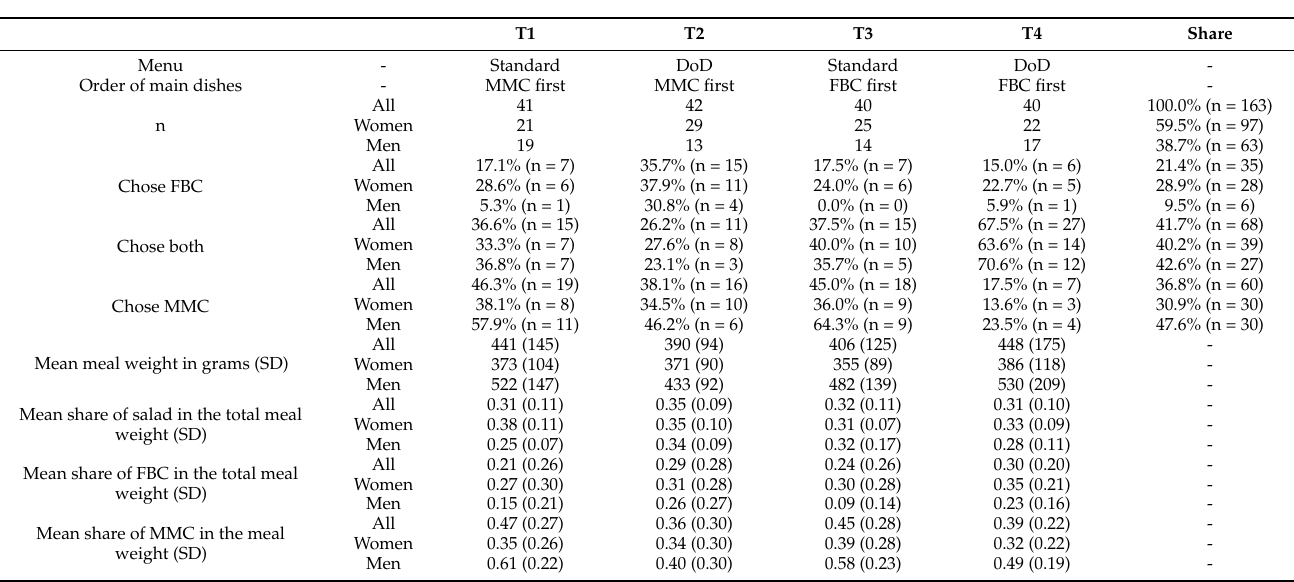
Table 2. The impact of Dish of the Day menu and sequence alteration in food selection by gender including only men and women. The “All”-category (n = 163) includes one participant in T1 who was unable to complete the questionnaire and two participants (one in T3 and one in T4) who reported their gender as